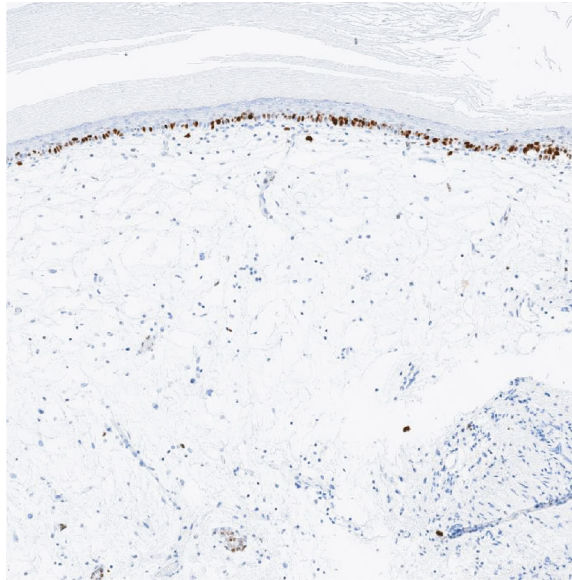
Figure 7: Staining for Ki67 (cell proliferation index) limited to the basal layer of the epithelium supports the benign nature of